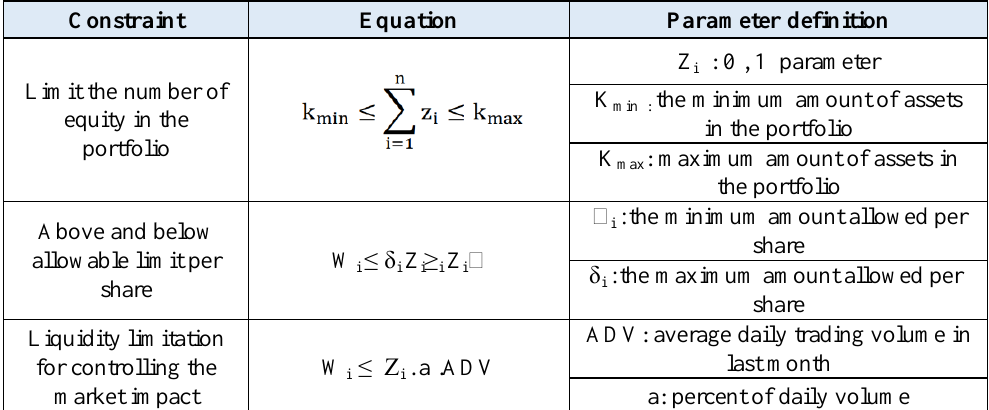
Table 5. Constraints used in the